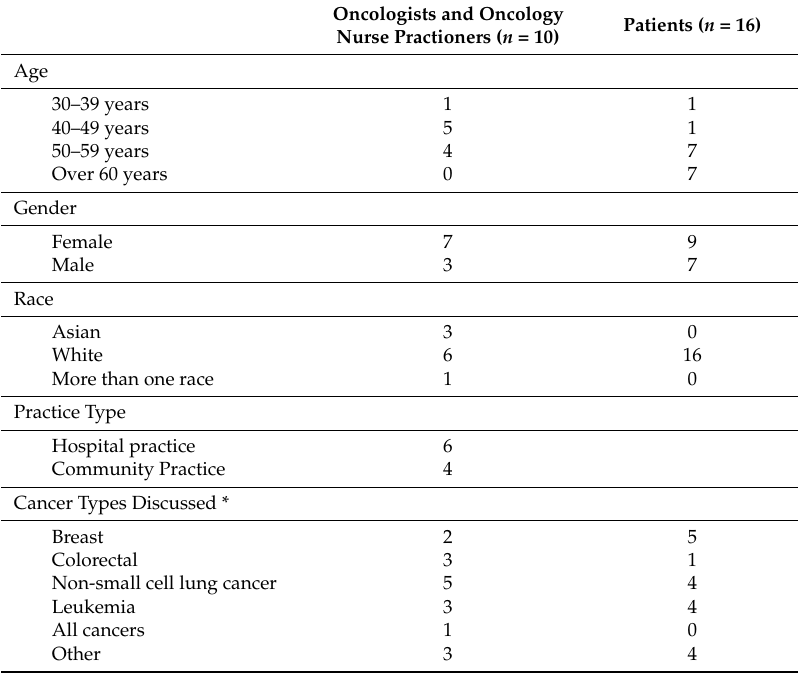
Oncologists and Oncology Nurse Practioners ( n =